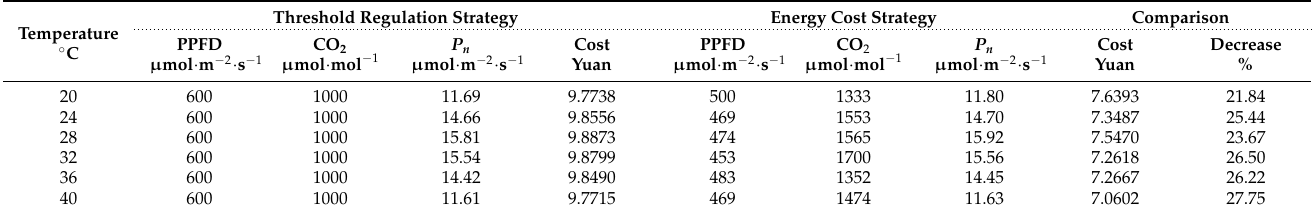
Table 2. Comparison of threshold regulation strategy and energy cost strategy. Temperature ◦ C